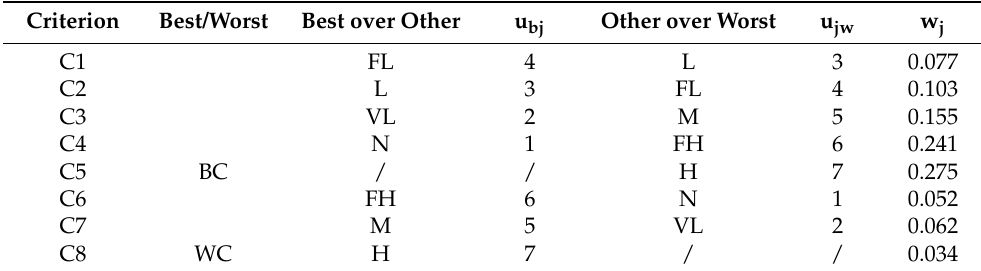
Table 3. Representative evaluations of the focus group and the final criteria weights.